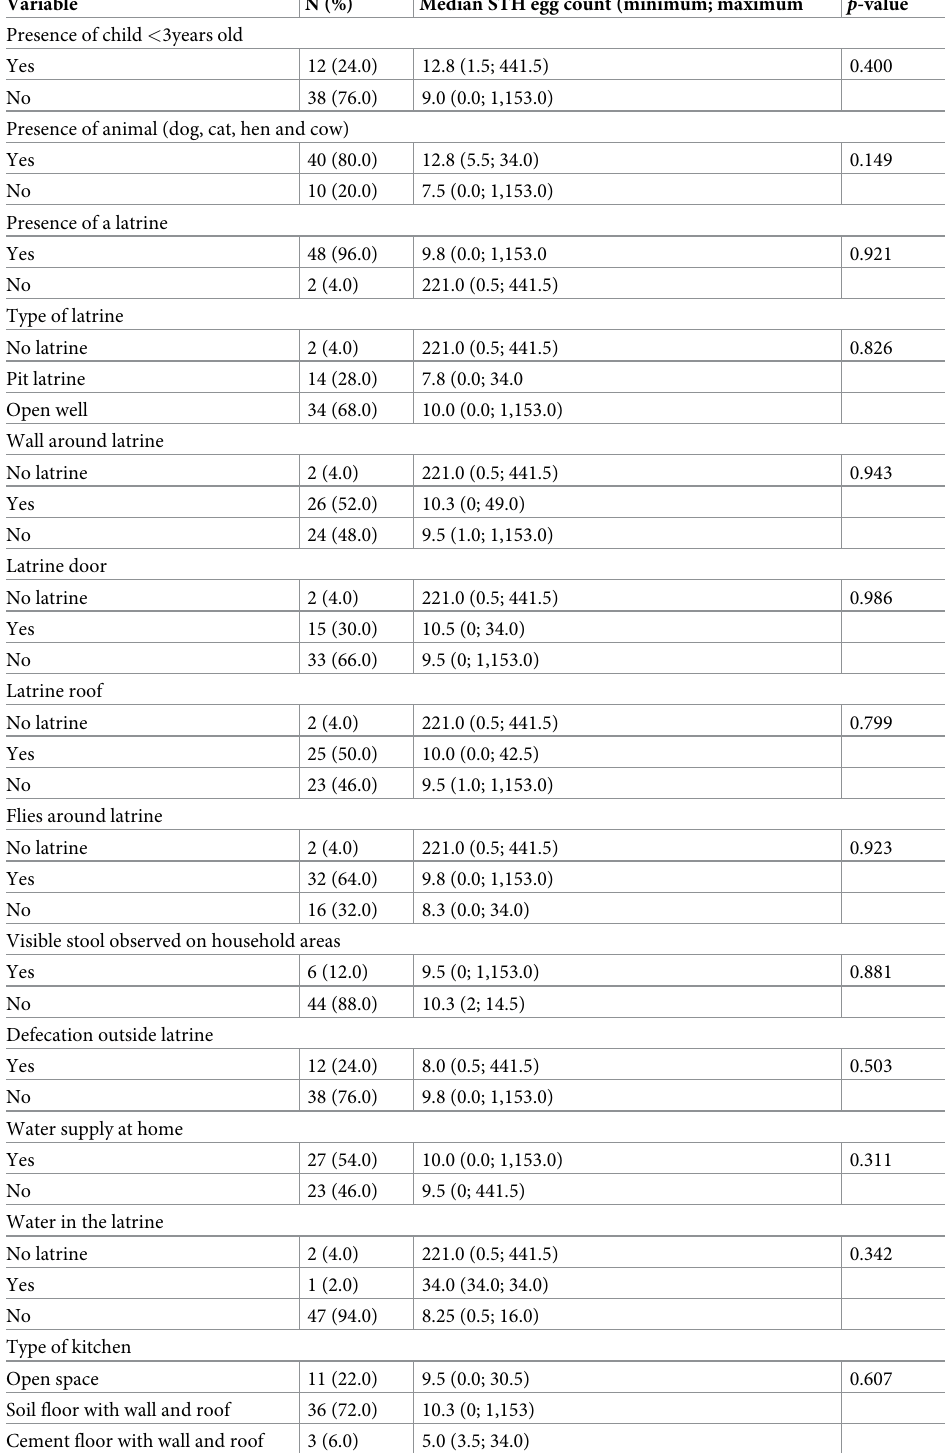
Table 2. The characteristics and the corresponding environmental contamination of 50 households in Jimma Town, Ethiopia. The environmental contamination measured by the mean soil-transmitted helminth egg counts across the samples. The p -value was based on the Wilcoxon rank sum test in case of two-level variables, while in case of variables with more than two levels it was based on the Kruskall Wallis